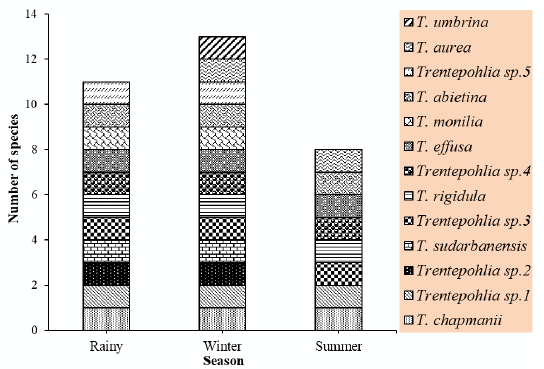
Figure 7 Diversity and composition of subaerial green algae genus Trentepohlia in the rainy, winter, and summer